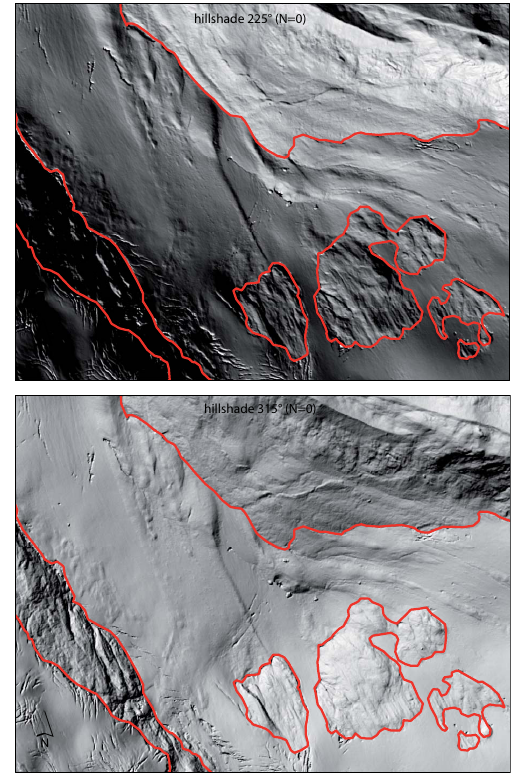
Figure 4. Hillshades from different view angles allow distinguish- ing smooth glacier surfaces from bedrock (position of the subset shown in Fig. 3).